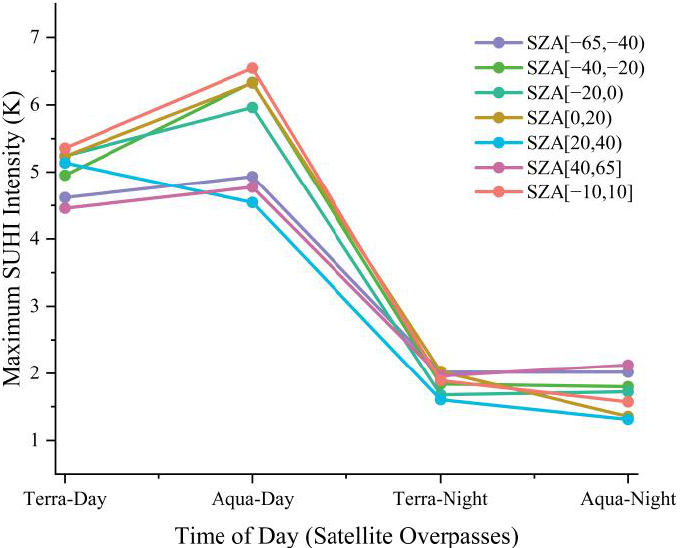
Figure 7. Line graph showing the maximum SUHI of each SZA group during each sensor overpass, the horizontal axis represents the four overpass times, the vertical axis represents the maximum SUHI, where the colored solid line is the variations in the maximum SUHI of each SZA group with respect to the satellite overpass time.